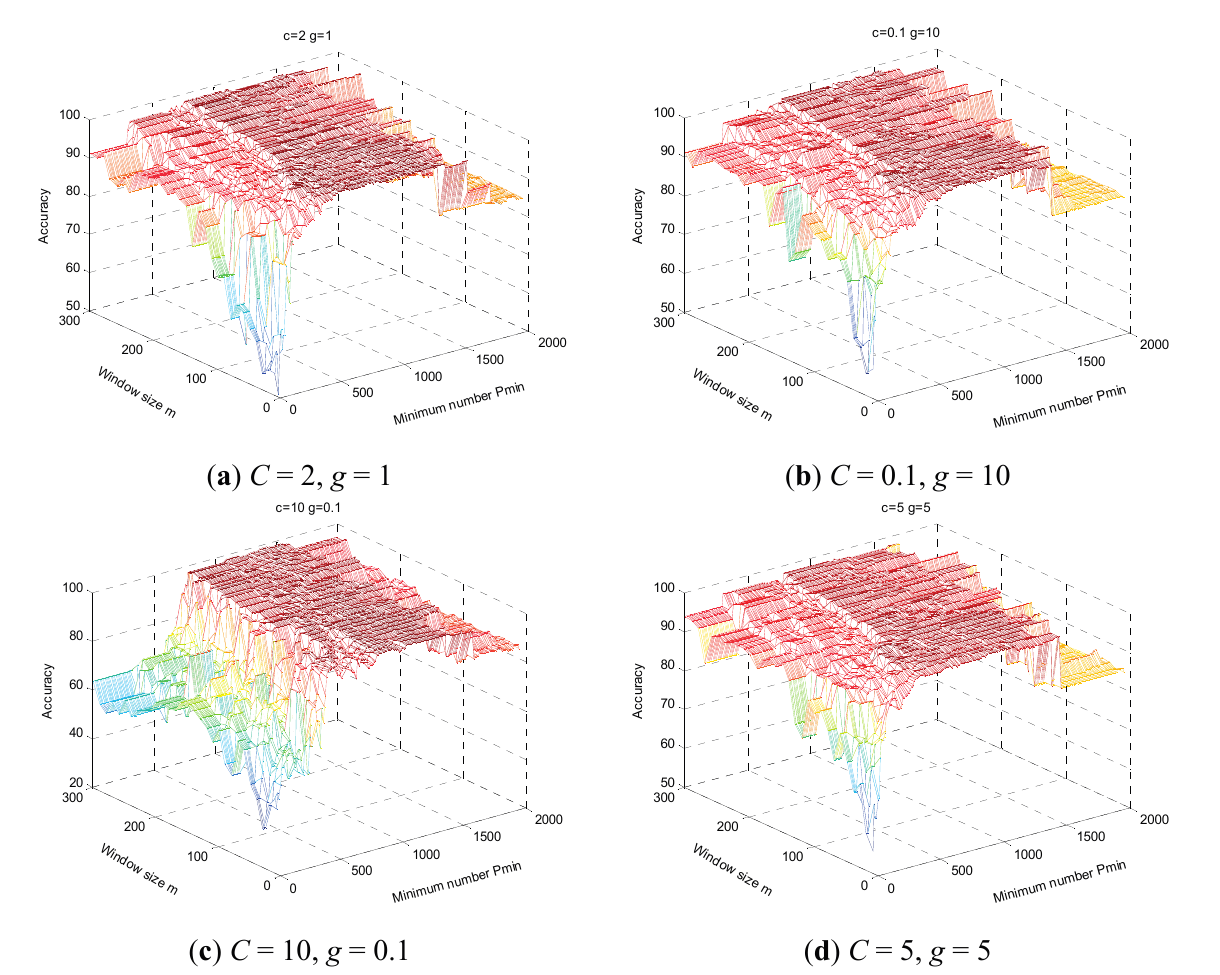
Figure 11. The performance of HHT-WMSC-SVM model varies with parameters ( m , Pmin ) under fixed parameters ( C , g ).( a ) C = 2, g = 1;( b ) C = 0.1, g = 10;( c ) C = 10, g = 0.1; ( d ) C = 5, g =